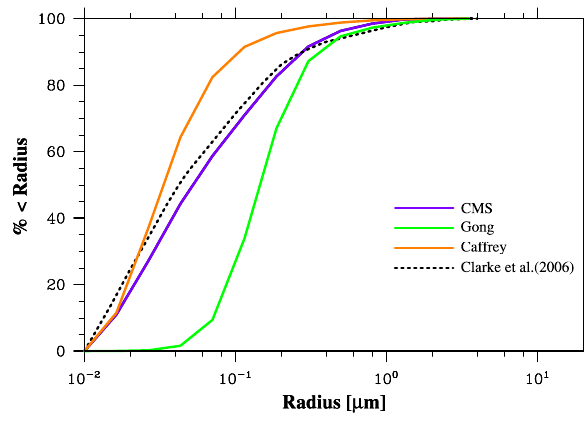
Fig. 15. Surface number size distribution versus dry radius com- pared between the modeled distribution and Lewis and Schwartz (2004) canonical distribution and O’Dowd et al. (1993) empirical relationship at Midway Island in June 2006. The model used a sol- ubility factor of 0.5. We multiply the whole size distributions by normalizing factors of 2.241, 0.891, 2.038, and 1.849 for Lewis and Schwartz (2004), O’Dowd et al. (1993), Gong, and Caffrey func- tion, respectively.